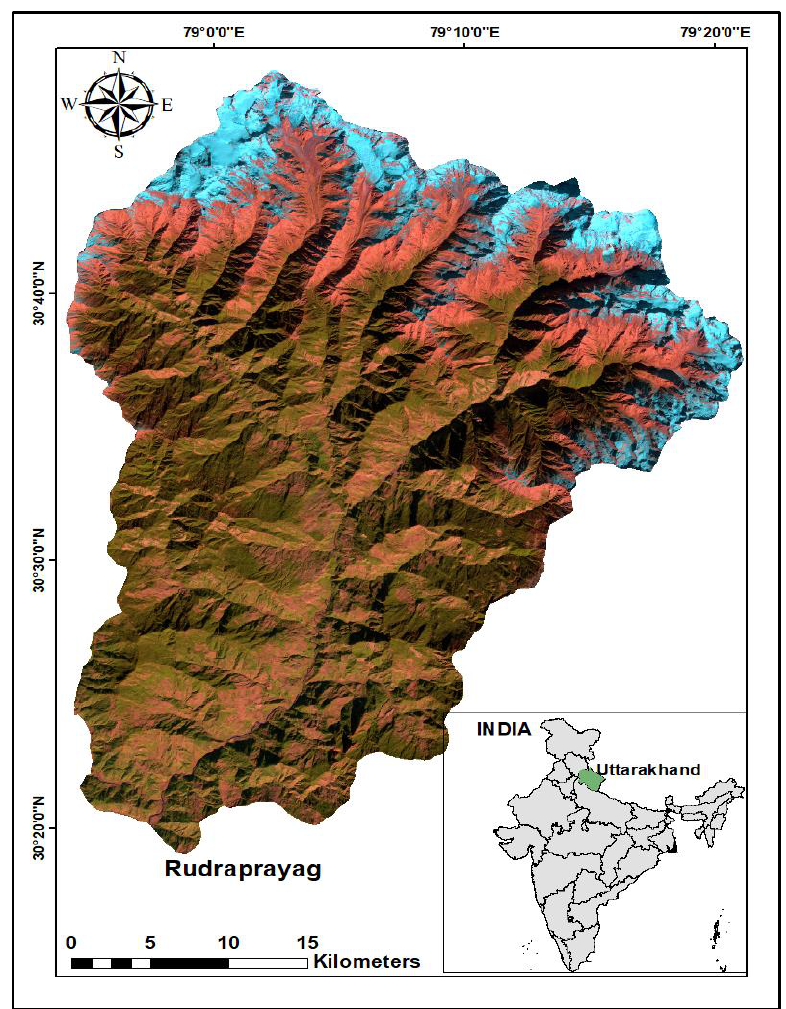
Figure 1. Location of study area using Landsat FCC image for